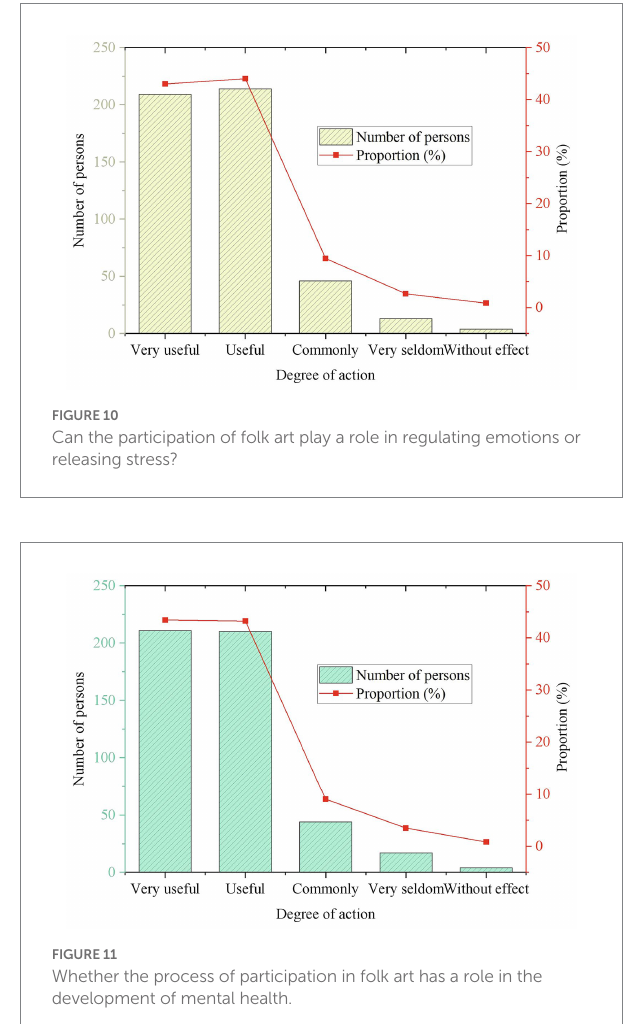
Figure 11 refers that the proportion of students who consider the folk art of Guozhuang dance very useful for the development of mental health is 36.95, and 49.75% think it is useful. It shows that a